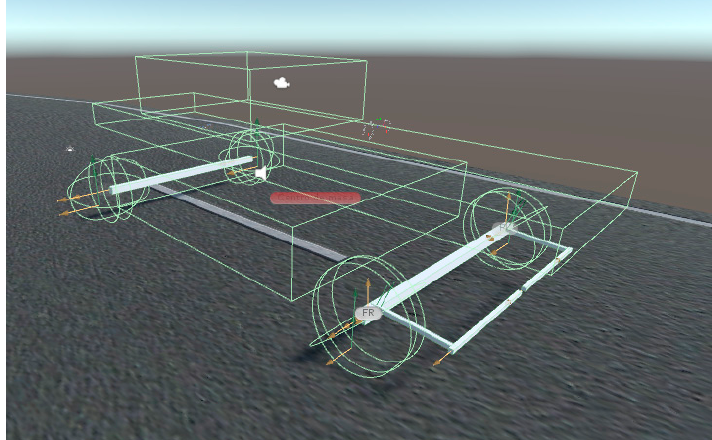
Figure 2. Elements of the virtual automobile (image rendered in Unity).